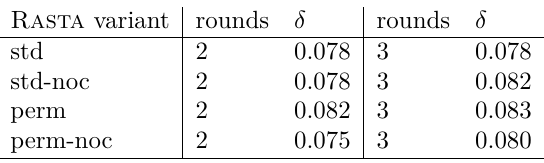
Table 7: Results of experiment for | B | =